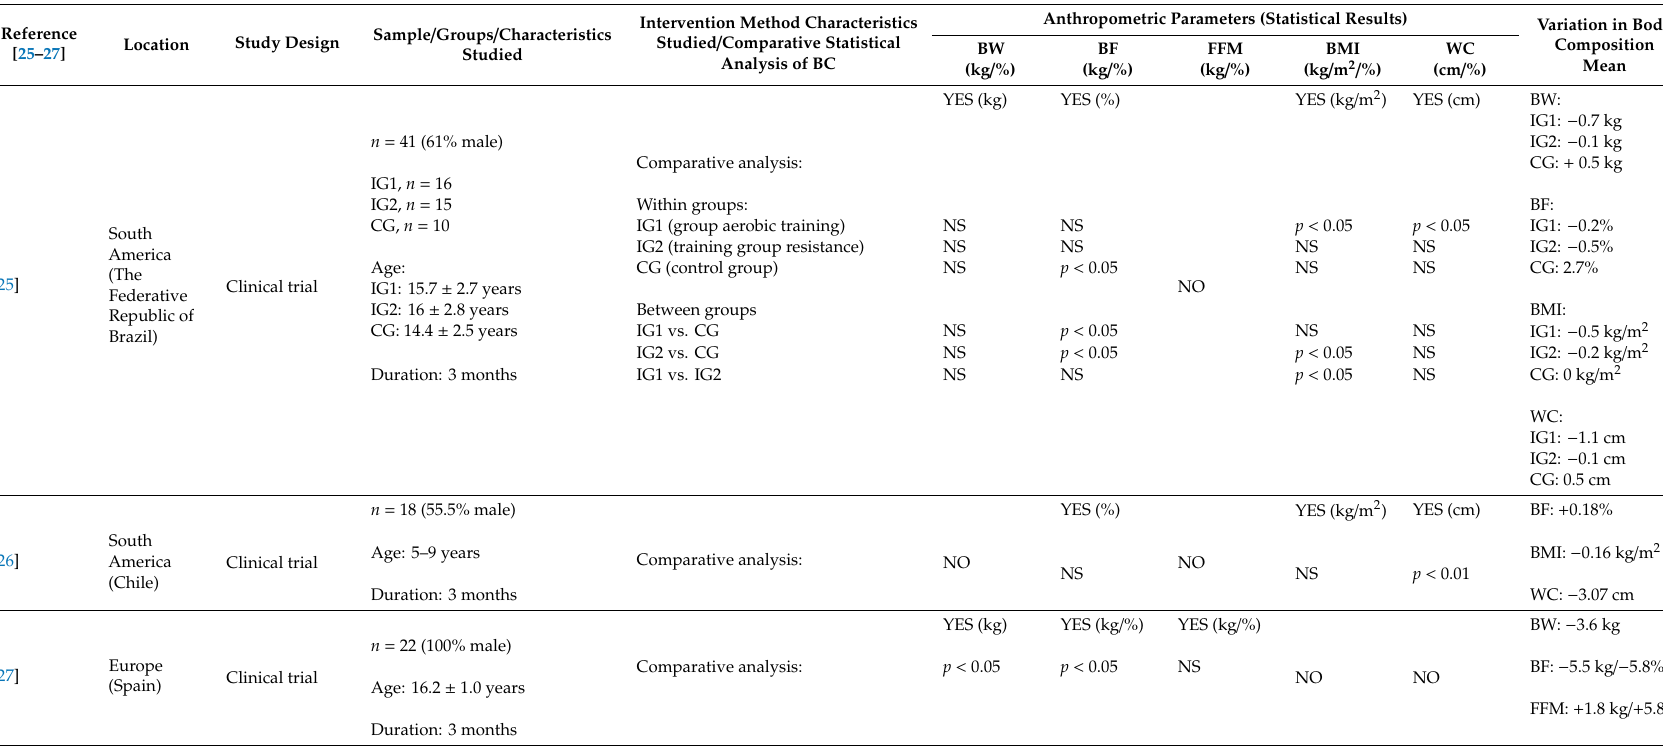
Table 2. Clinical trials including children and adolescents su ff ering DS in which body composition was monitored (intervention in physical exercise). Reference Study [25–27] Location